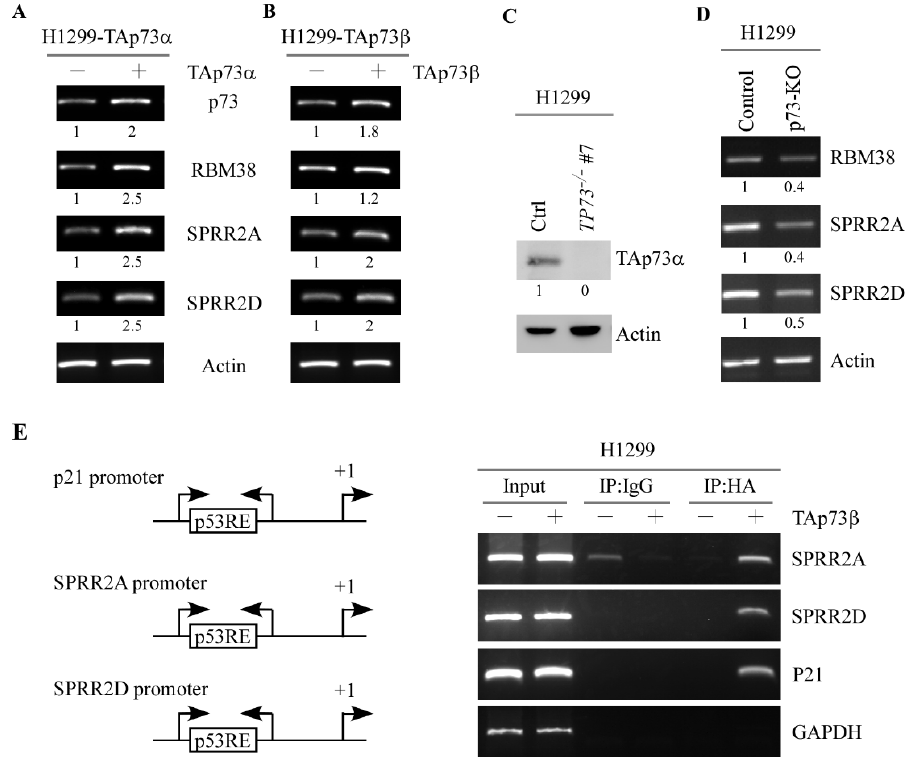
Figure 2. p73 directly induces SPRR2A and SPRR2D expression via binding to their promoters. ( A , B ) The levels of p73, RBM38, SPRR2A, SPRR2D, and actin transcripts was examined in H1299 cells that were uninduced or induced to expression TAp73 α ( A ) or TAp73 β ( B ) for 24 hours. ( C ) The levels of TAp73 α and actin proteins were examined in isogenic control and TP73 -KO H1299 cells by Western blot analysis. (D) The levels of RBM38, SPRR2A, SPRR2D, and actin transcripts were examined in in isogenic control and TP73 -KO H1299 cells by RT-PCR analysis. ( E ) Left panel: Schematic presentation of the p21, SPRR2A, and SPRR2D promoters with the locations of potential p53-REs and PCR primers for ChIP assays. Right panel: ChIP assays were performed as described in Materials and Methods. Anti-HA antibody was used to immunoprecipitate HA ‐ p73–DNA complexes.